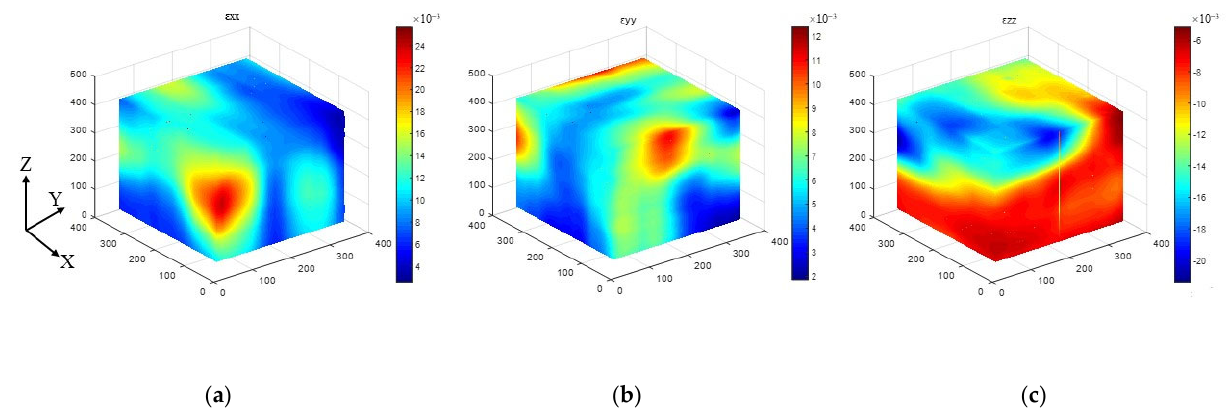
Figure 10. Strain fields of cement mortar under 50 MPa. ( a ) ε xx , σ = 50 MPa; ( b ) ε yy , σ = 50 MPa; ( c ) ε zz , σ = 50 MPa.